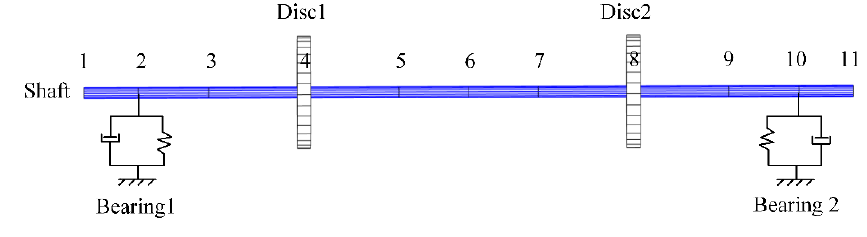
Figure 2. Finite element model.